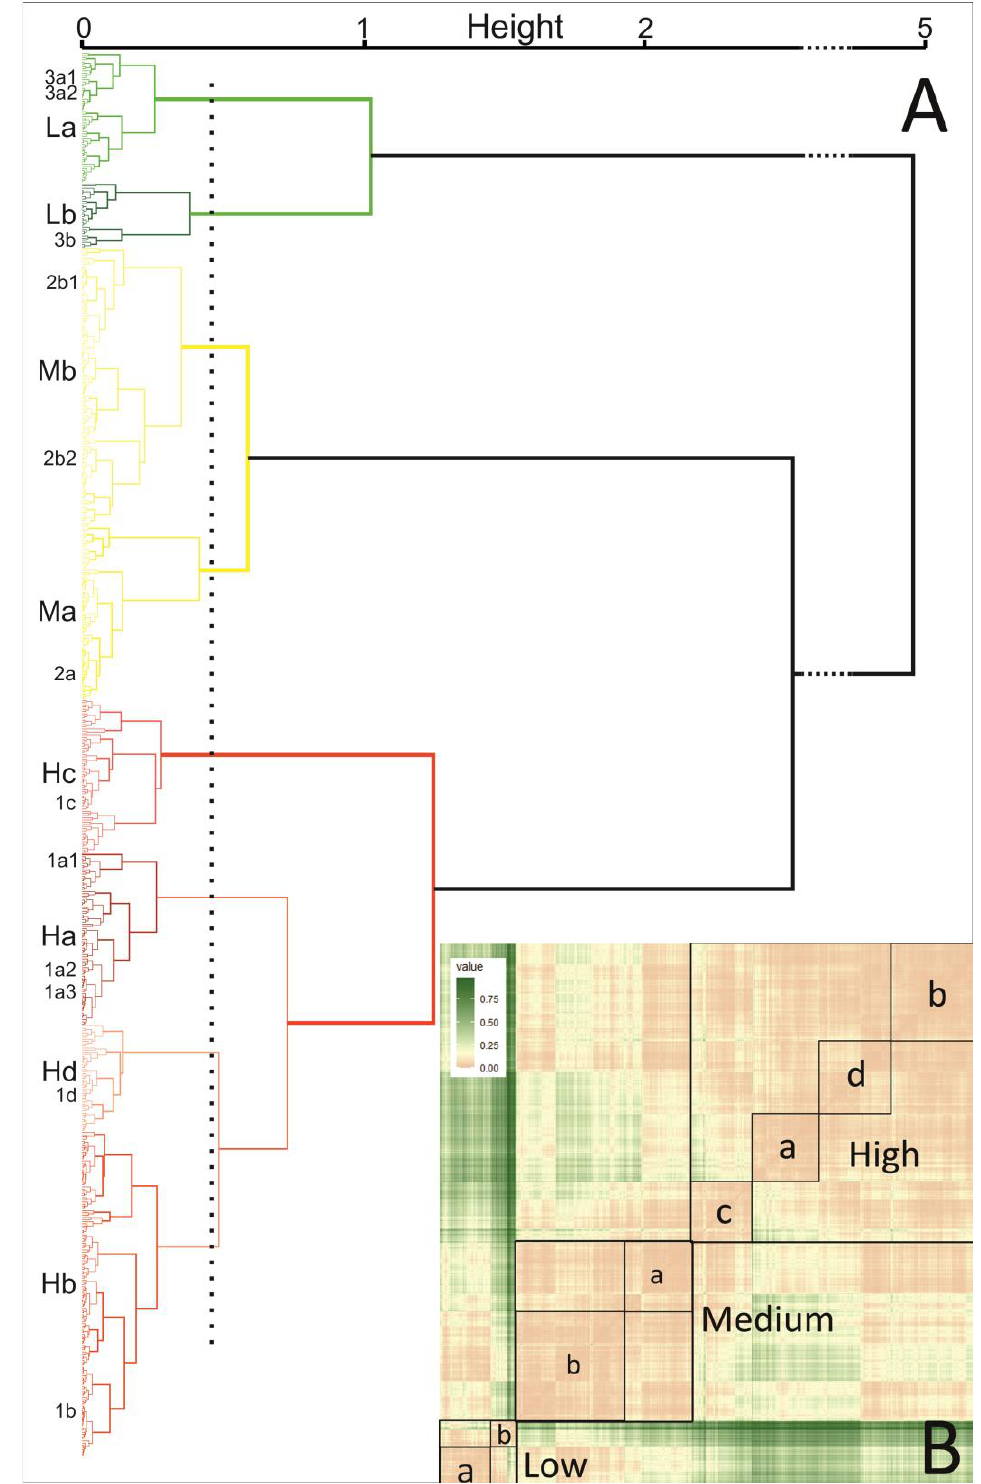
Figure 5. Dendrogram chart ( A ) and heat map ( B ) based on distance matrix between unique segments, grouped into relief types and subtypes. Dotted, vertical line marks the height of cutting, dividing the collection into 8 subgroups (subtypes). Small letters on vertical axis (1a1, 1a2, etc.) show location of the geomorphon example maps presented in Figure 6. Colors of types and subtypes on dendrogram are according to Figures 4 and 6.